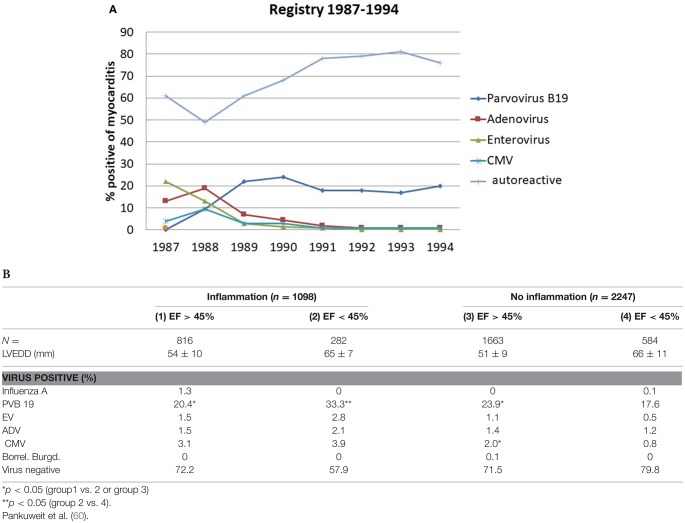
(A) Epidemiological shift in the Myocarditis Registry from entero-(green line) and adenoviruses (brown line) to Parvovirus B 19 (dark blue line) in the late 1980-ties. The number of patients with nonviral myocarditis (light blue line) varied from 50 to 80% in the same time span. (B) PCR-based etiology of viral and autoreactive myocarditis and dilated cardiomyopathy without inflammation (4th column) [modified from Pankuweit et al. (60)]. PCR-Based etiology of myocarditis and dilated cardiomyopathy. Investigation of endomyocardial biopsies from 3345 patients (1997–2003).